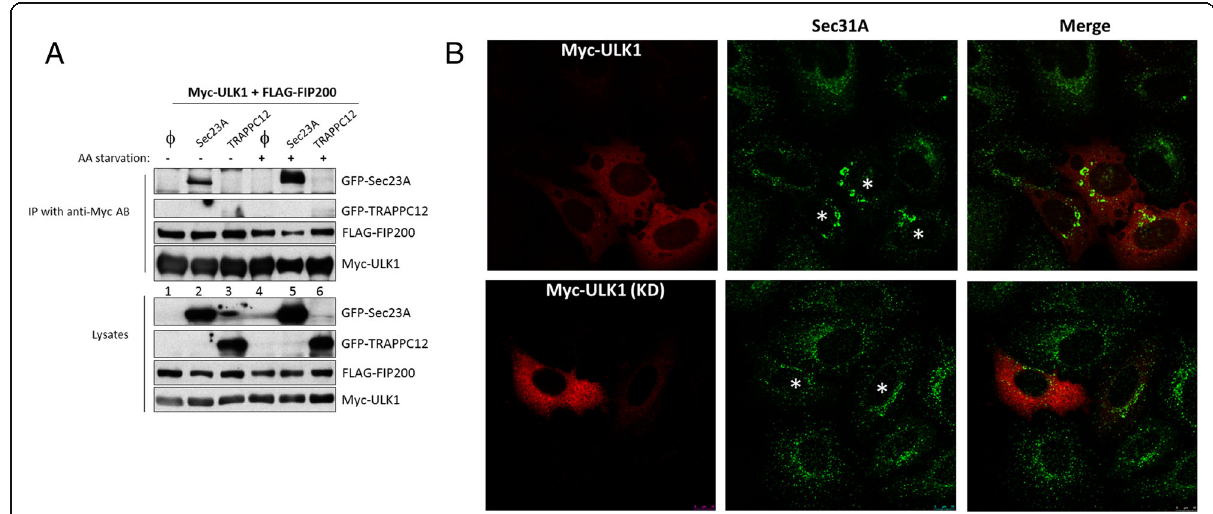
Fig. 1 ULK1 interacts with Sec23A and affects ERES morphology. a Sec23A but not TRAPPC12 was pulled down by ULK1 in co-immunoprecipitation experiment. Myc-ULK1, FLAG-FIP200 were co-transfected with the indicated GFP fusion DNA constructs. Myc-ULK1 was immunoprecipitated with anti-c- Myc antibody and the presence of GFP-Sec23A or GFP-TRAPPC12 was determined. b ULK1 affects the morphology of ERES. Myc-ULK1 wild type or kinase dead (KD) mutant were co-transfected with GFP-Sec23A into Hela cells. ULK1 transfected cells were determined by immunostaining of TRITC conjugated anti-Myc antibody. ERES was detected with Sec31A staining. Asterisks in the Merge pictures indicate cells transfected with